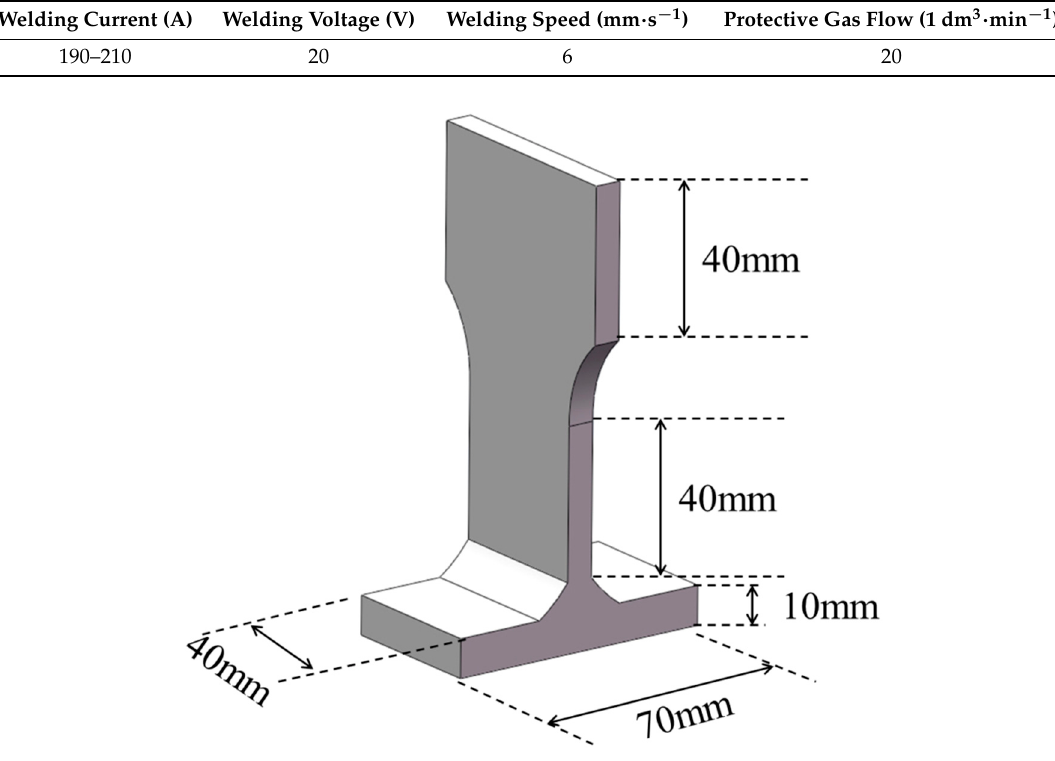
Figure 2. Fatigue test for T welded joint of 6082 aluminum alloy with MIG welding.